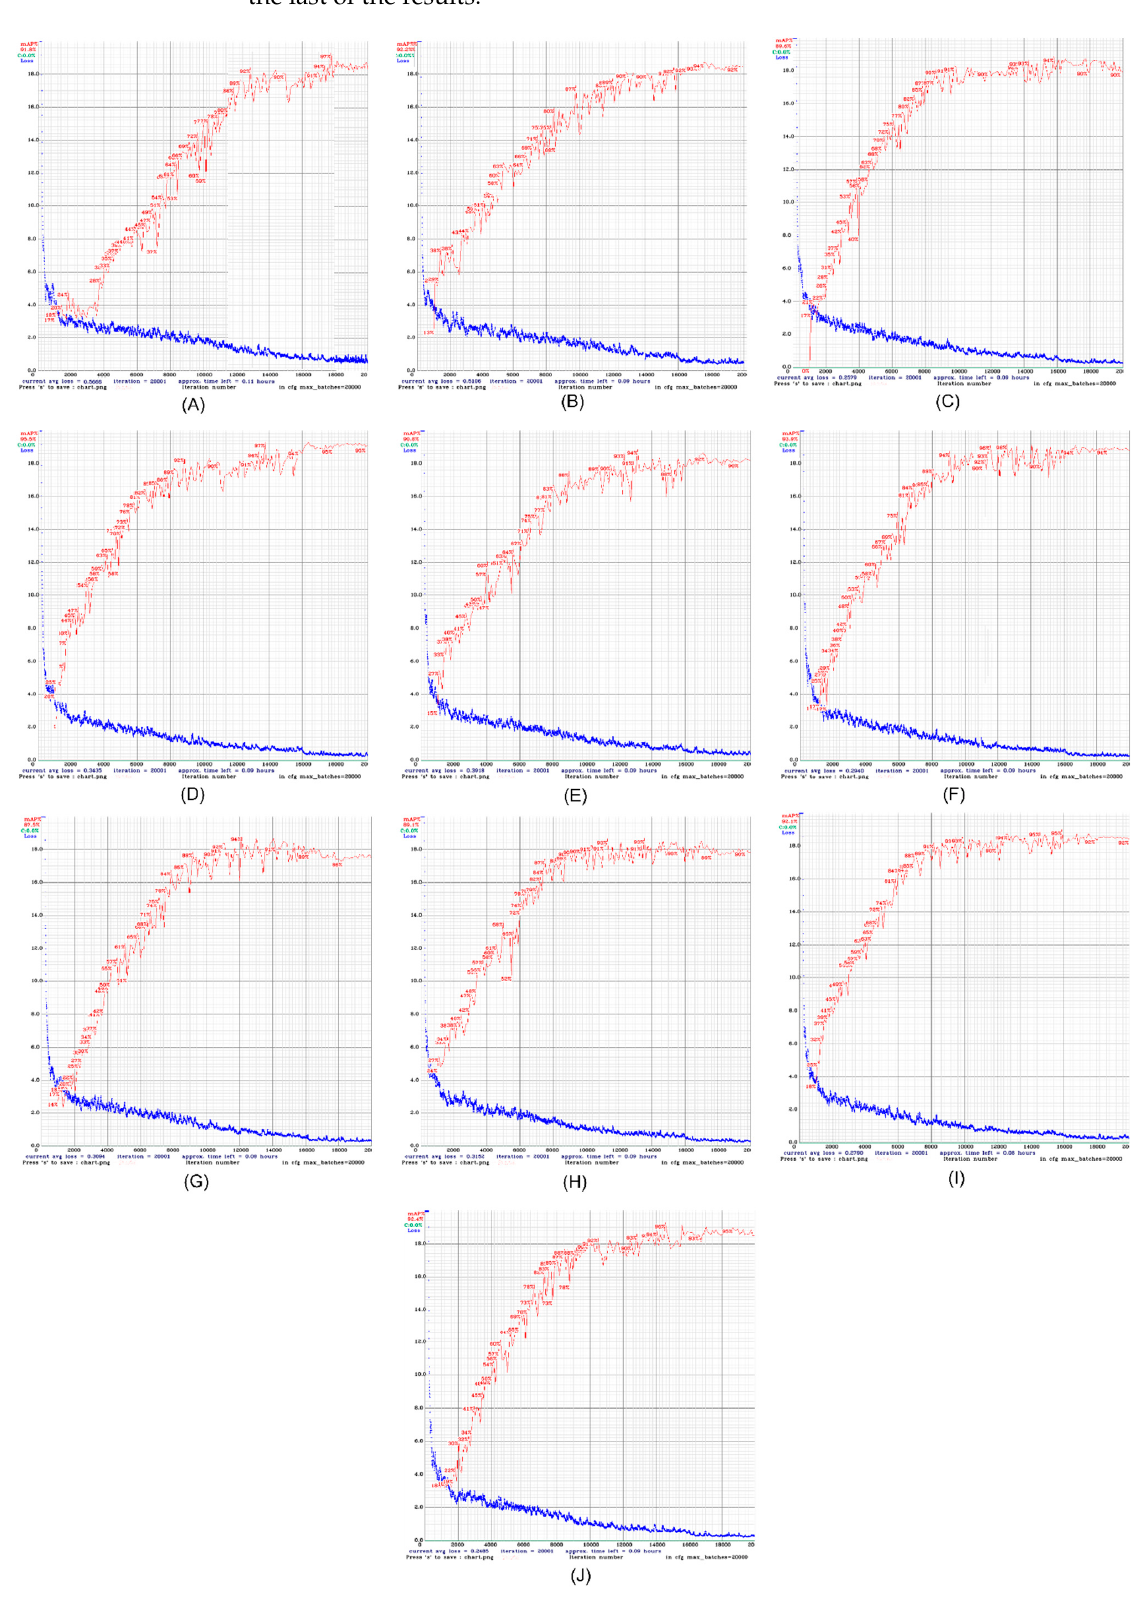
Figure 9. mAP and loss curves of the experimental training.